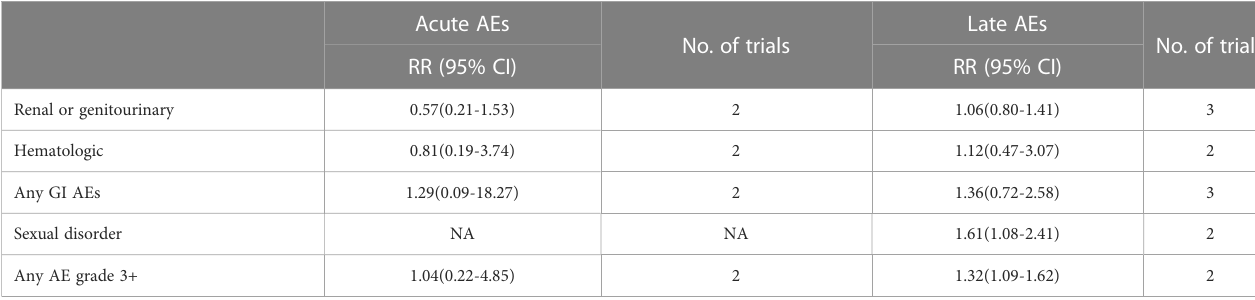
GI, gastrointestinal; grade 3+, grade 3 or worse; AE, adverse event; RR, risk ratio; CI, con fi dence interval; NA, not